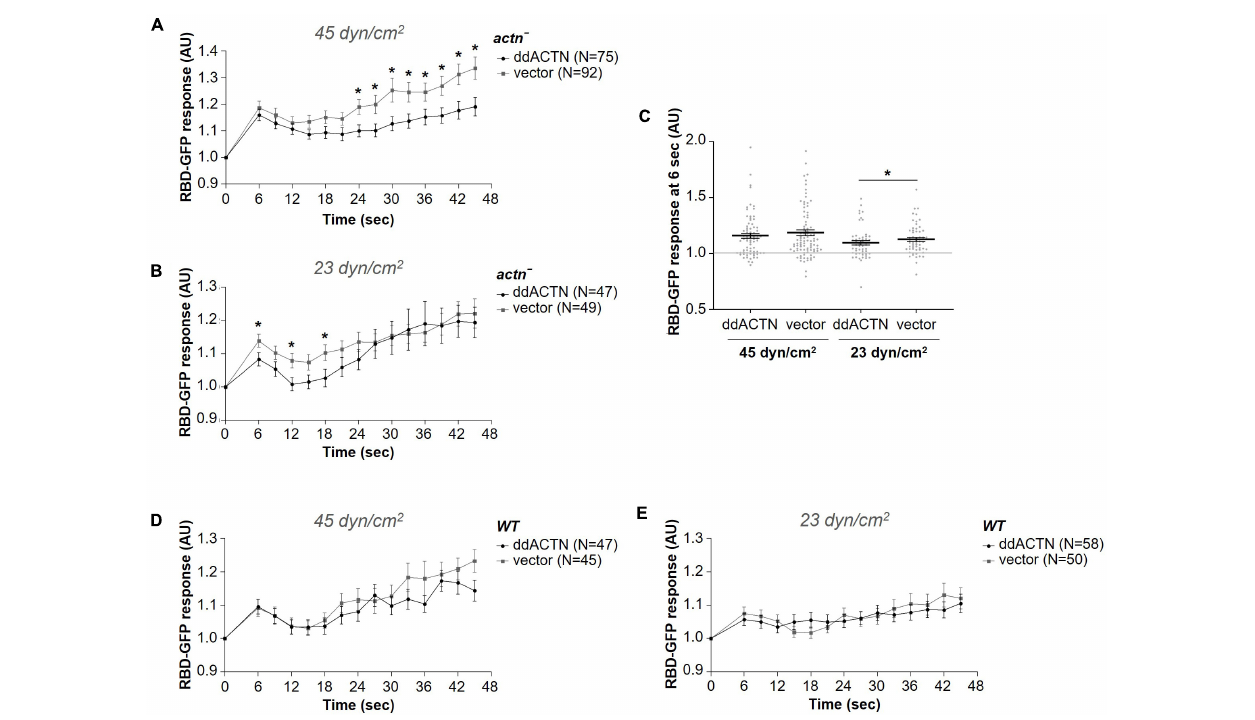
FIGURE 7 | α -actinin is not required for the activation of the signal transduction network in response to shear flow. Activation of Ras, which reflects activation of the signal transduction network, was measured by the relocalization of RBD-GFP from the cytosol to the cell cortex. actn - (A–C) or wild-type (WT) (D,E) cells expressing RBD-GFP and either mCherry-tagged ddACTN or empty vector were imaged every 3 s by epifluorescence microscopy with a GFP filter set under 630X magnification with oil immersion. Shear flow was applied at time 0 for 2 s. The shear stress delivered to the cells was 45 dyn/cm 2 (A,D) or 23 dyn/cm2 (B,E) . Data is displayed as mean ± SE. Number of cells analyzed is provided in the key and was pooled from seven (A) or three (B,D,E) independent experiments. (C) RBD-GFP response values for individual cells from panels (A,B) at the 6 s time point. Horizontal lines with error bars correspond to mean ± SE. A line at the RBD-GFP response value of 1.0 is shown as a reference to indicate basal levels at time 0. * P < 0.05, ** P <